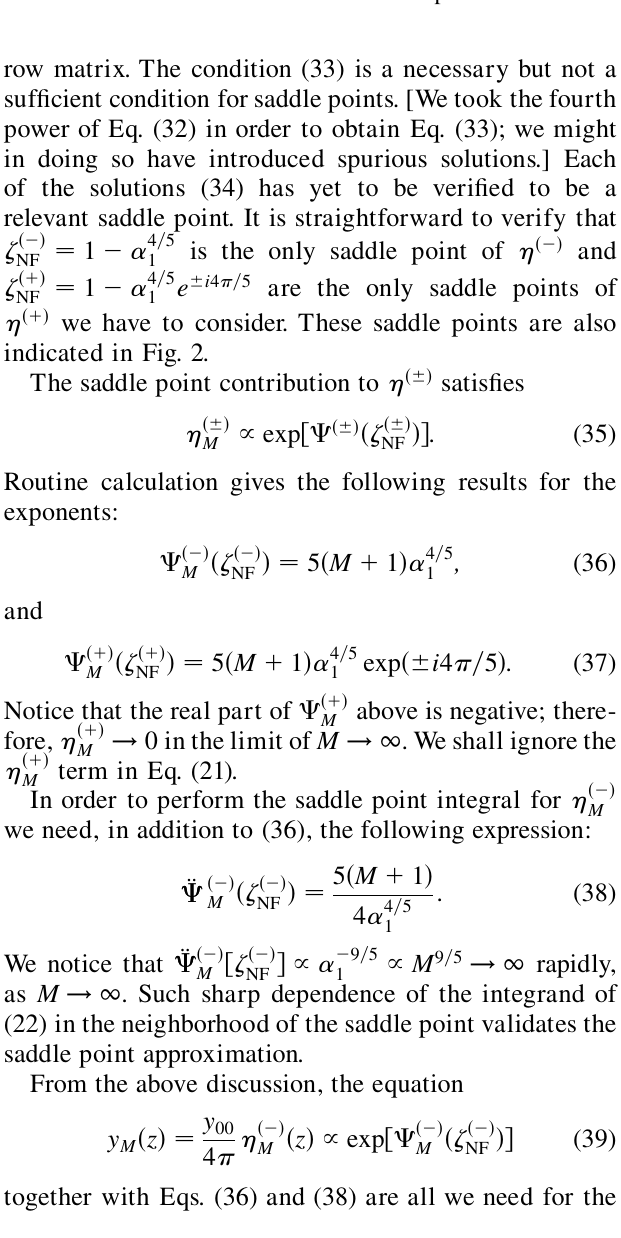
FIG. 2. The contour used for the saddle point calculation. The dashed curve indicates that the contour is closed at j % j ! 1